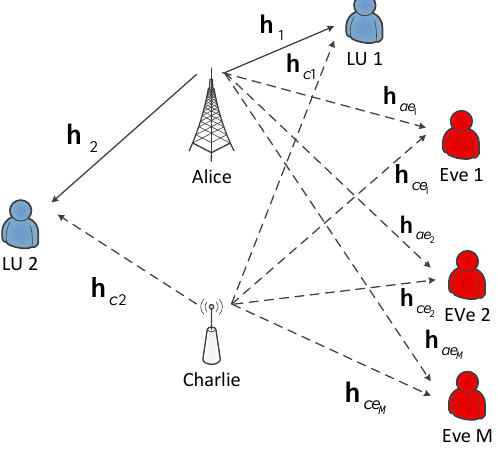
Figure 1. Secure transmission in cooperative MISO-NOMA